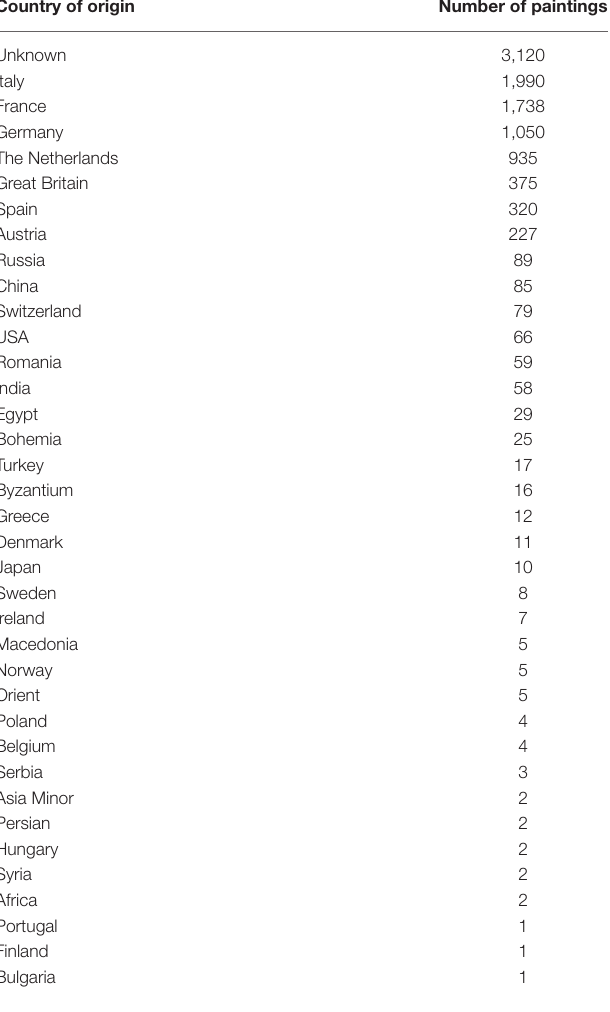
TABLE 2 | Summary for the individual observers. Observer Sex Age No. of